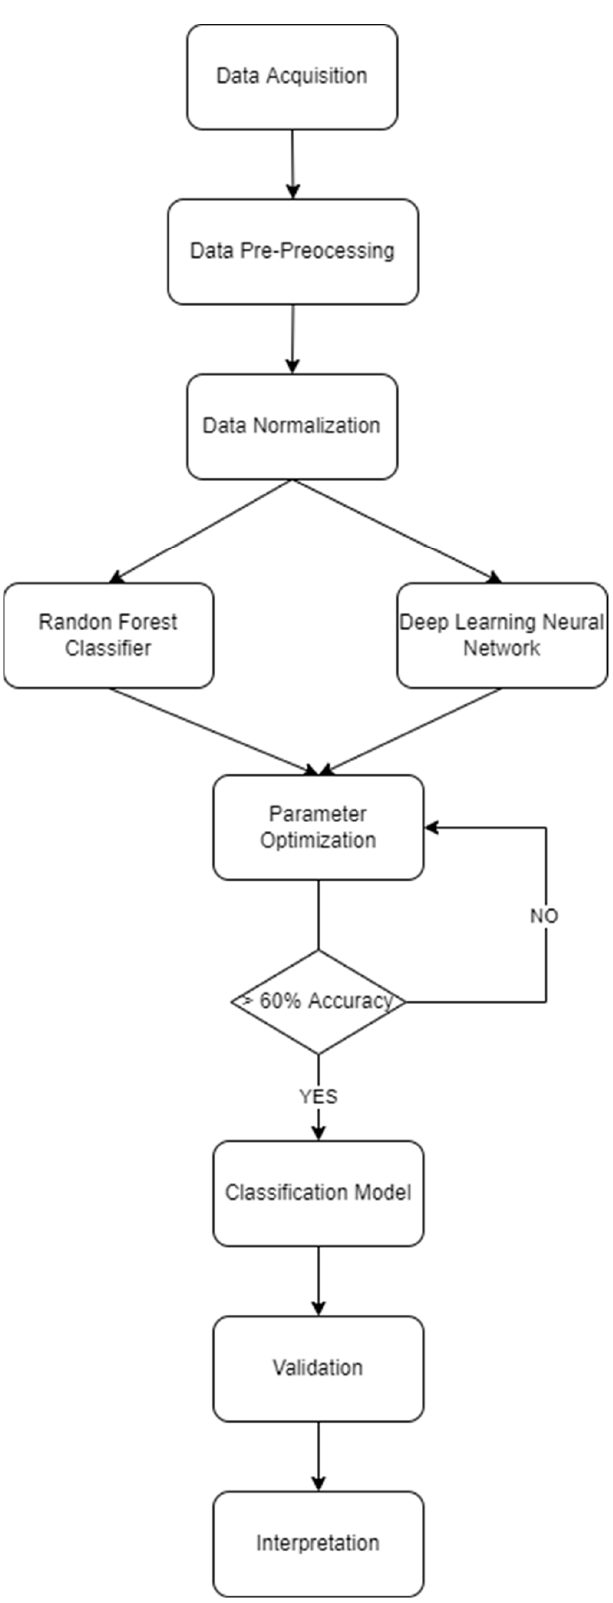
Figure 2. Methodological Flowchart.